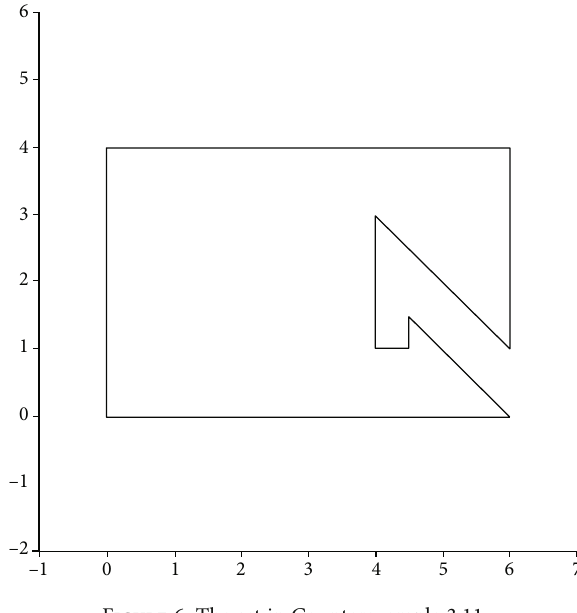
Figure 6: The set in Counterexample 3.11.